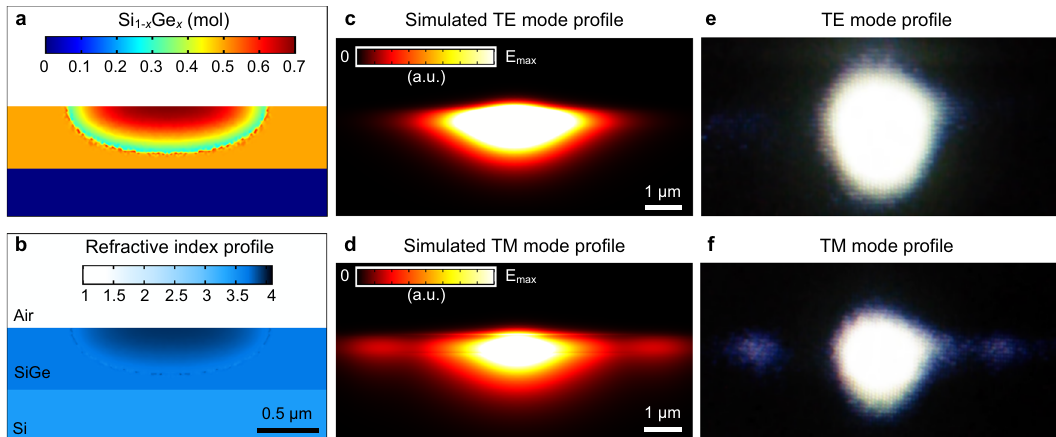
Fig. 5 Laser-written in-plane longitudinal SiGe heterostructures as graded-index optical waveguides. a Simulated spatial redistribution of Ge molar fraction x ( r ) and b calculated refractive index n ( x ) of the cross-section of a SiGe heterostructure laser-written at a scan speed of 200 mm s − 1 . Simulated c transverse electric (TE) and d transverse magnetic (TM) polarized mode pro fi les obtained by modal analysis using the refractive index pro fi le n ( r ) in b . Infrared (IR) camera image showing the experimentally captured intensity pro fi les for the e TE and f TM polarized modes of light, which was free space coupled into the 1 cm long laser-written SiGe waveguides using a fi ber laser emitting at 2 µ